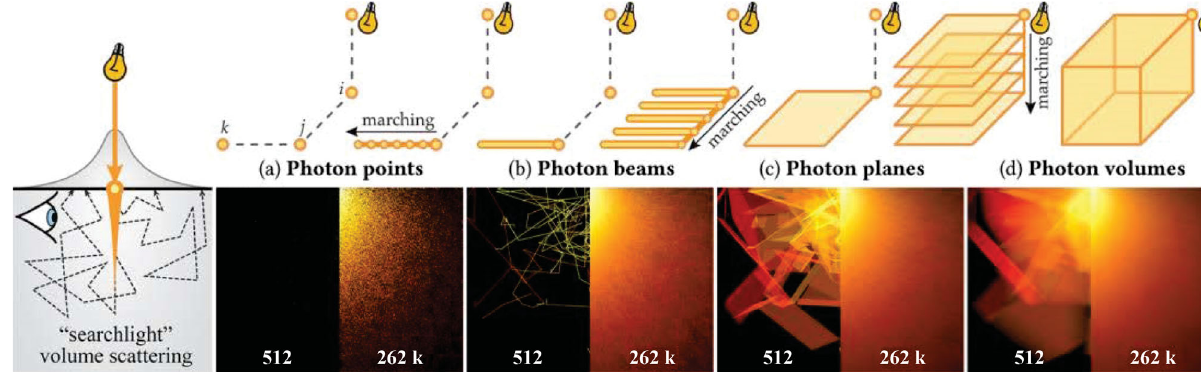
Fig. 4 Different estimators and their results. Reproduced with permission from Ref. [5], c (cid:2) ACM 2017.